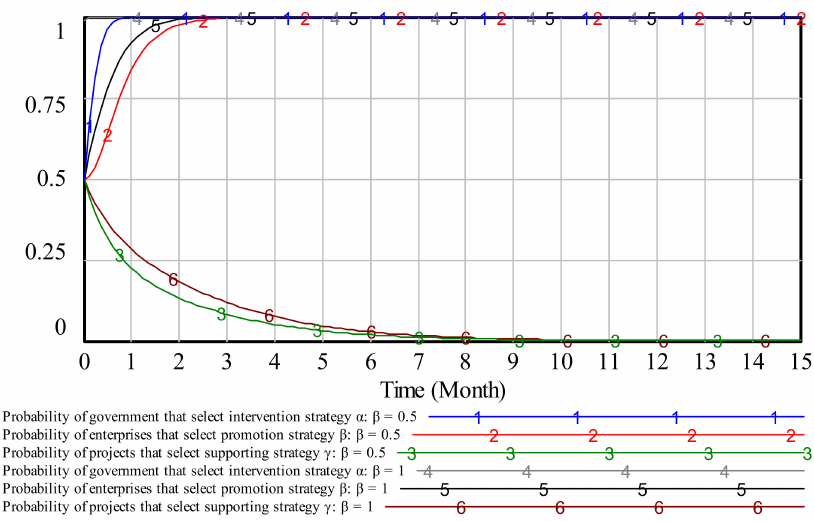
Figure 7. In BAU2, the evolution of enterprises and projects under government intervention.